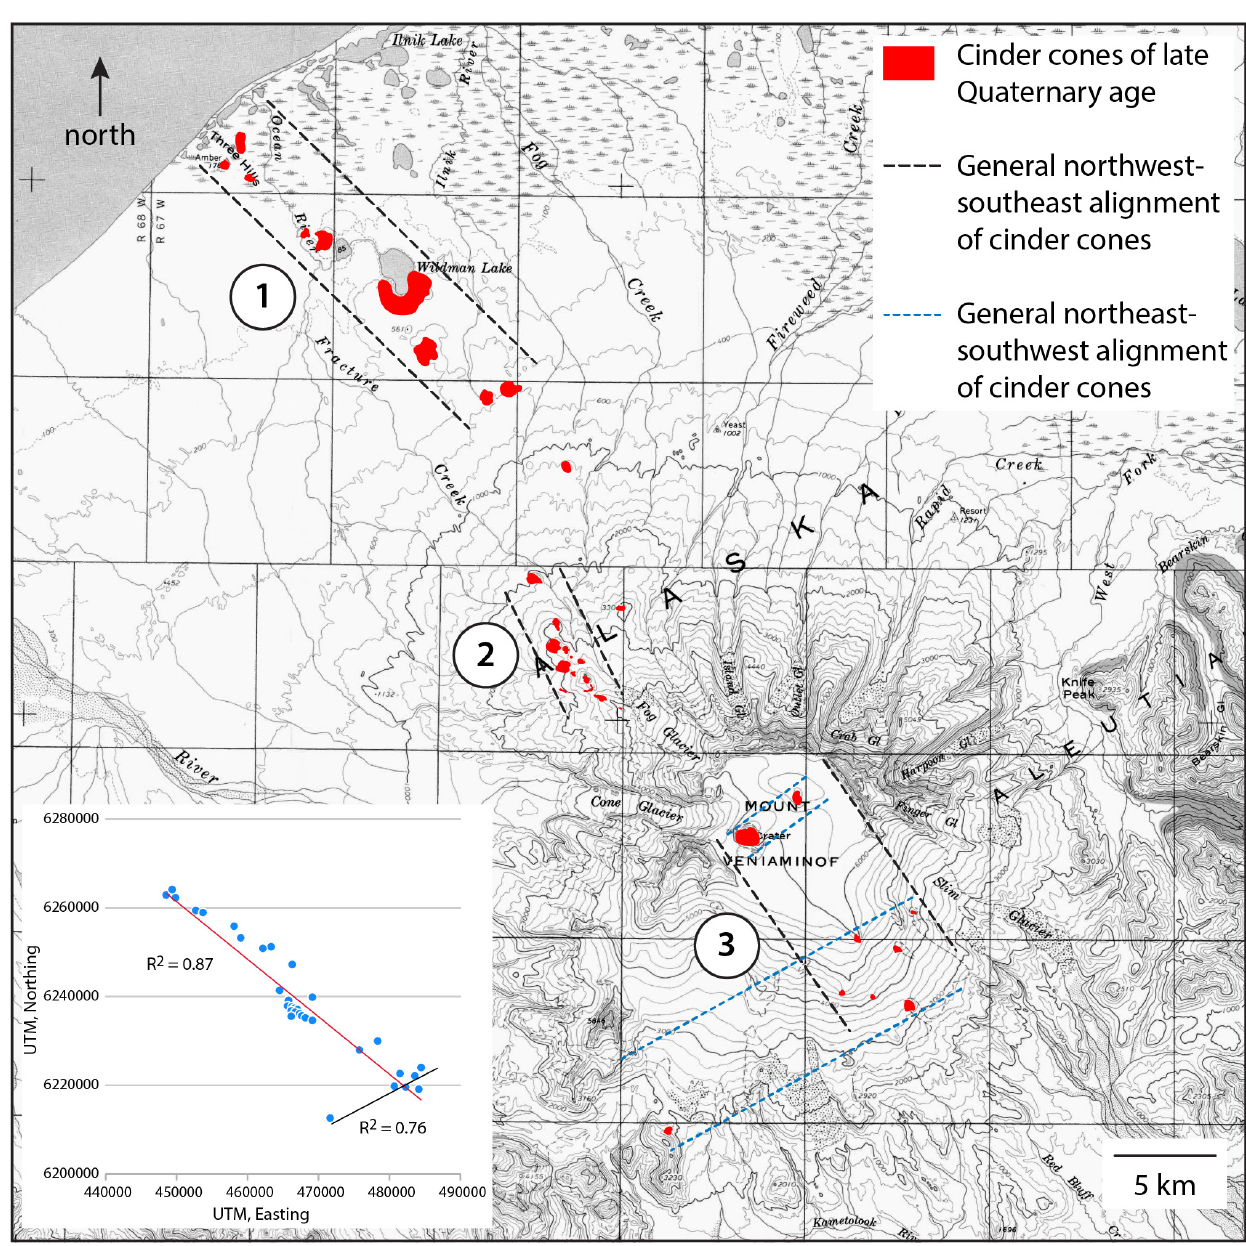
Figure 6: Cinder cones at Veniaminof Volcano. Three clusters of cinder cones are apparent. Cluster 1 is the oldest and these cones are partly to entirely vegetated and are mantled with pyroclastic deposits associated with a mid-late Holocene caldera-forming eruption of Veniaminof. Cluster 2 is intermediate in age and these cones are sparsely vegetated and lack a pyroclastic cover, indicating that they are younger than the last caldera- forming eruption. Cluster 3 includes the historically active cone inside the caldera (cone A), cone B, and several fresh unvegetated, unglaciated cones on the south flank of the edifice. The dashed lines indicate the general spatial alignment of the cone clusters. Note that it is unclear if the cones of group 3 have a northwest-southeast orientation or a northeast-southwest orientation. Plot in lower left gives the location of the cinder cones in UTM coordinates and shows a strong linear alignment ( R 2 = 0.87). A plausible northeast-southwest orientation of the group-3 cinder cones is indicated by the black line ( R 2 =